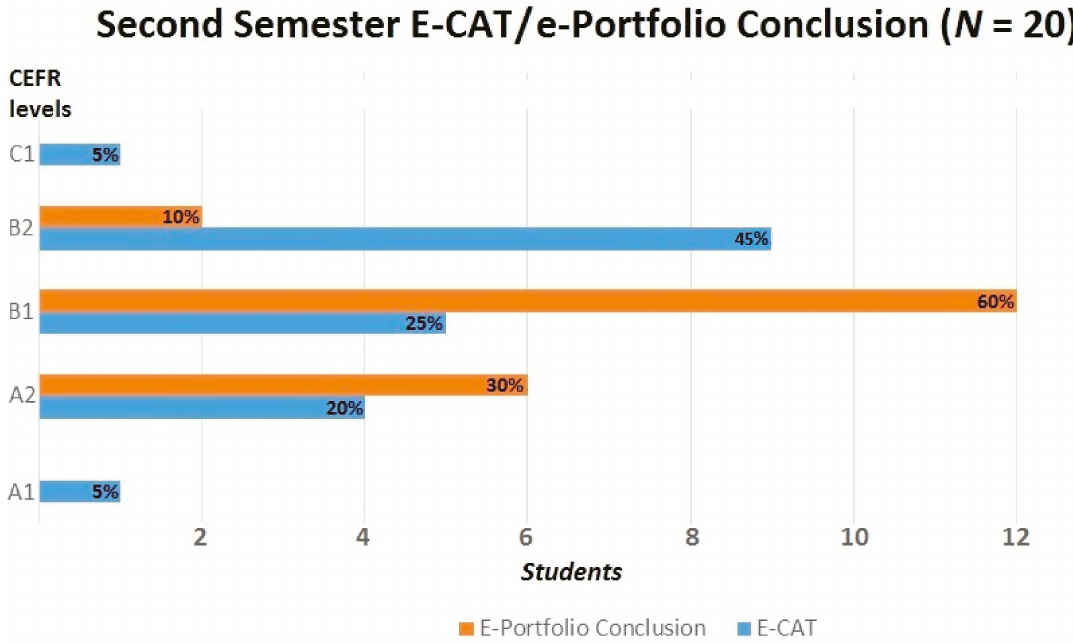
Figure 7. Second semester E-CAT/electronic (e) -portfolio